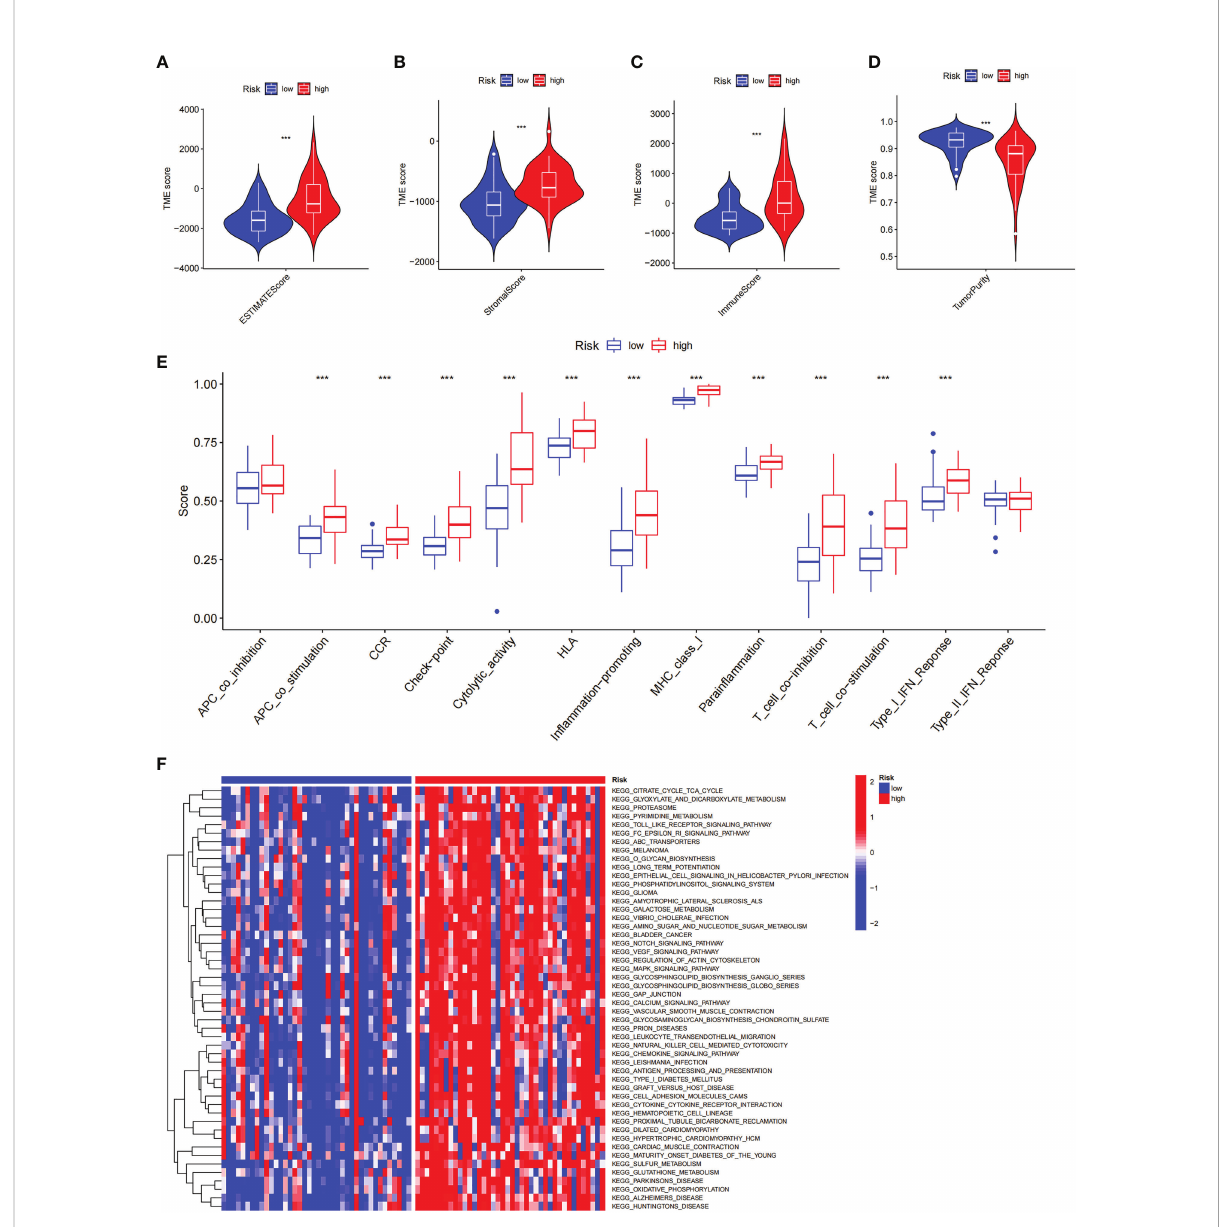
FIGURE 10 The immune landscape in the high and low ICD risk groups. (A-D) Violin plots of the stromal score, immune score, ESTIMATE score, and tumor purity between the high and low ICD risk groups. (E) Box plots show the differences in immune-related functions between the high and low ICD risk groups. (F) The heatmap of GSVA enrichment in two groups. ***P <